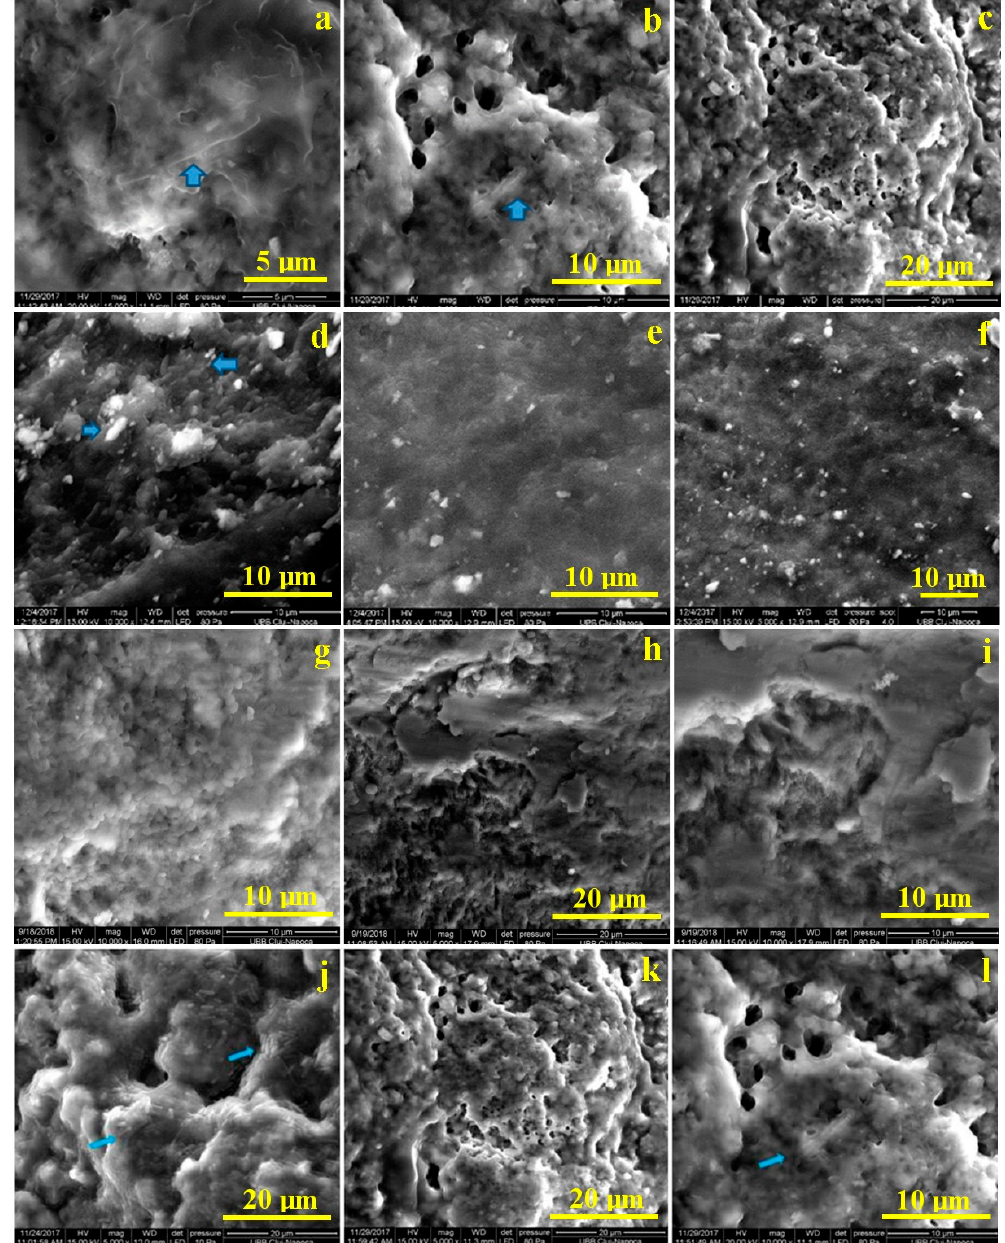
Figure 7. SEM images of teeth before and after treatment with photosensitizers: ( a ) after bacterial colonization, 15,000 × magnification; ( b ) after treatment with commercial gel HELBO, 10000 × magnification; ( c ) 5000 × magnification; ( d ) after bacterial colonization, 10,000 × magnification; ( e ) after treatment with experimental gel AM, 10000 × magnification; ( f ) 5000 × magnification; ( g ) after bacterial colonization, 10,000 × magnification; ( h ) after treatment with experimental gel O, 5000 × magnification; ( i ) 10,000 × magnification; ( j ) after bacterial colonization, with 5000 × magnification; ( k ) after treatment with experimental gel CU, 5000 × magnification; ( l ) after treatment with gel CU, 10,000 × magnification.